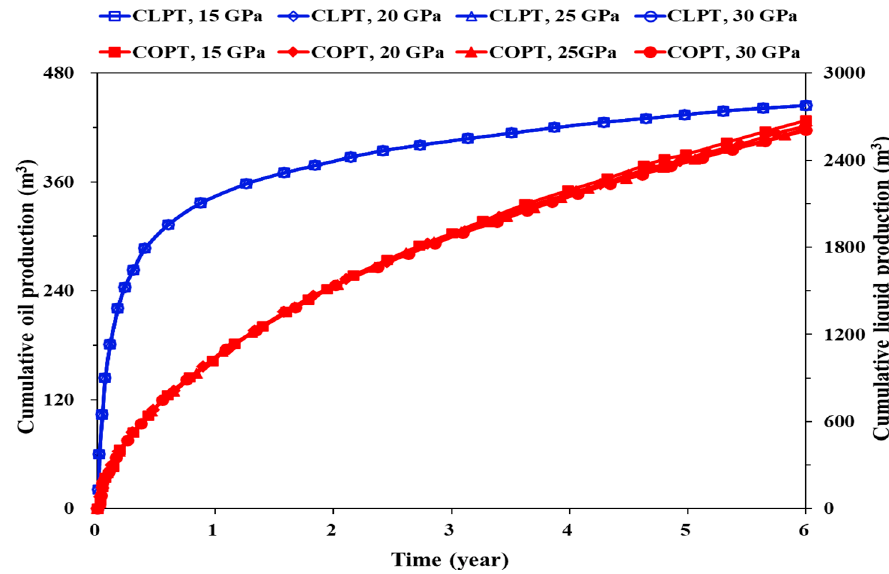
Figure 21. Production performance curves for different Young’s modulus values.